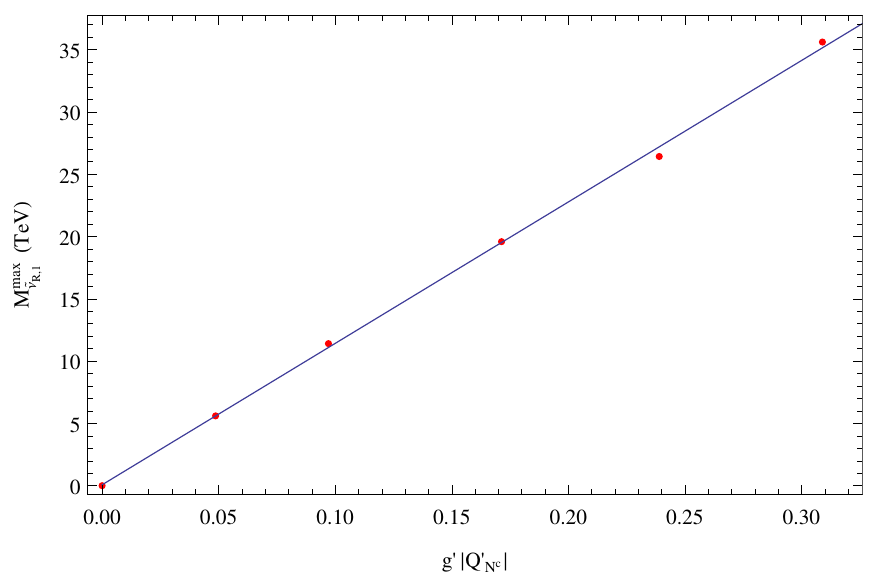
Figure 5. The upper limit on M ~ (cid:23) R; 1 derived from the relic density as a function of j Q 0 N C j . The straight line shows a linear (cid:12)t to the six numerical